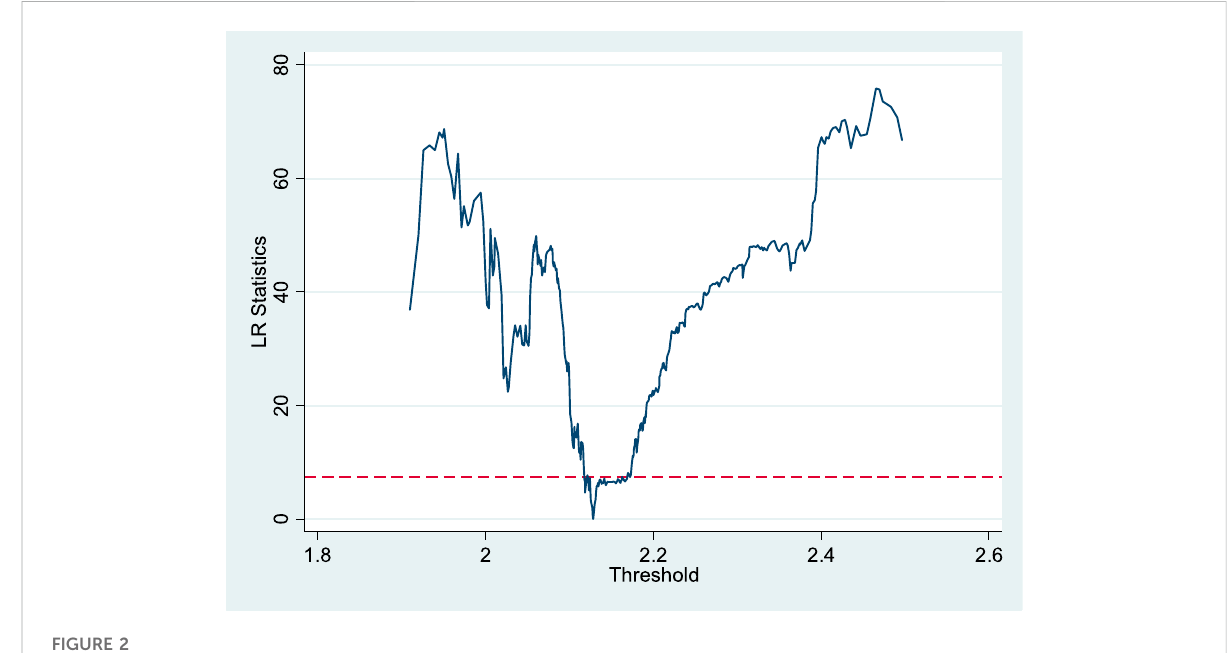
FIGURE 2 Single threshold con fi dence interval